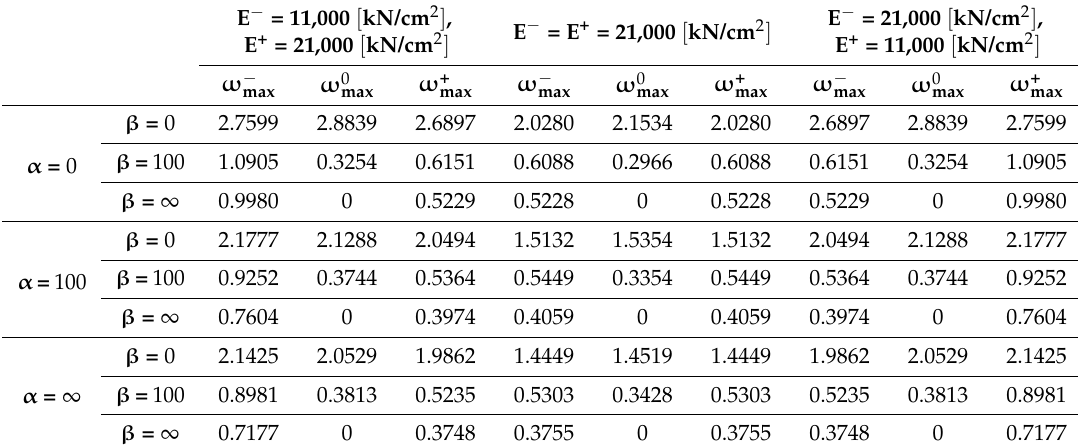
Table 2. The effect of modulus of elasticity E on maximal bending (cm) depending on the change of α and β in the plate system when the clamp condition is given on the boundaries ( ν − = ν + = 0.3 ).